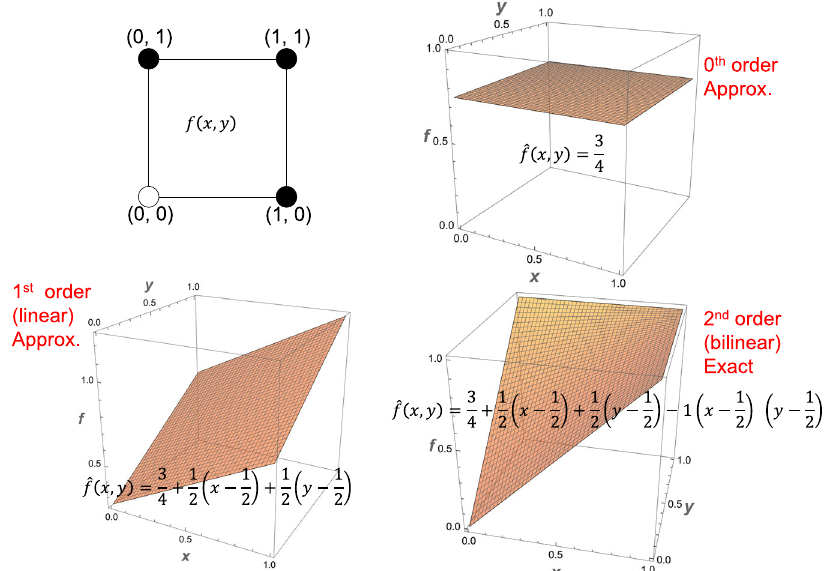
Fig. 5 The various approximations of a Boolean function in increasing order of nonlinearity. The logical OR function is represented as a 2D hypercube (top left) with the coordinate values representing input combinations and the color of the circles representing the corresponding outputs (white = 0, black = 1) and is approximated using Taylor decomposition as the 0th order approximation (top right) showing only the fi rst term, the mean output bias; the 1st order approximation (bottom left) including the linear terms; and fi nally the 2nd order exact form (bottom right) including all the terms. Table 2. Values of partial the derivatives in the Taylor decompositions of the generalizations of basic Boolean